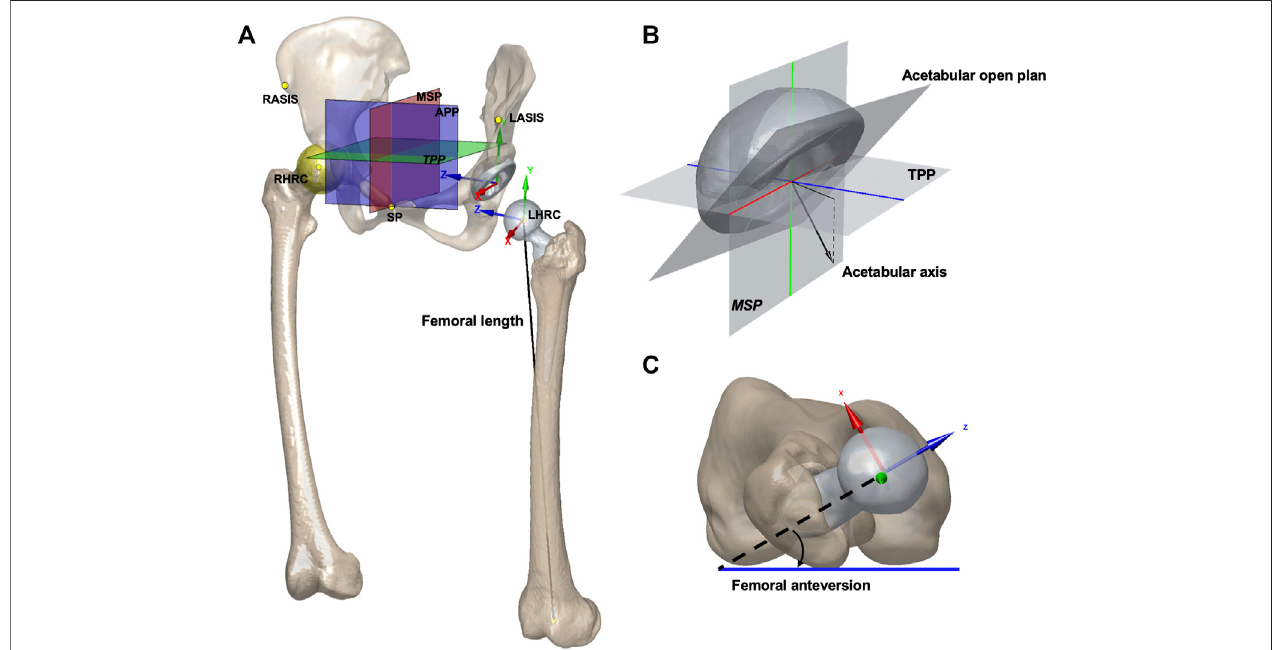
FIGURE 1 | (A) APP, TPP, MSP, and hip rotation center were shown on models of the pelvis and implants. The femoral length was calculated as the absolute length. The origin of the pelvic coordinate system was at the center of the acetabular cup. The pelvic z -axis was parallel to a line connecting the right and left ASISs and pointing to the right. The pelvic x -axis was parallel to a line lying in the plane de fi ned by the two ASISs and the midpoint of the two posterior – superior iliac spines, orthogonaltothe Z -axis,andpointinganteriorly.Theoriginofthefemoralcoordinatesystemwasatthecenterofthefemoralhead.Thefemoral y -axiswasparallelto thelongaxisoftheproximalfemoralshaft.The x -axiswasparalleltothenormalvectoroftheplaneformedbythe y -axisandthecenterofthefemoralhead.Thepelvicand femoral local coordinate systems were de fi ned for describing the hip joint rotations. SP: symphysis pubis. (B) Acetabular open plane and axis are shown. The cup anteversion was de fi ned as the angle between the transverse axis (blue) and the acetabular axis projected onto the TPP. The cup inclination was de fi ned as the angle between the longitudinal axis (green) and the acetabular axis. (C) Measurement for femoral anteversion is